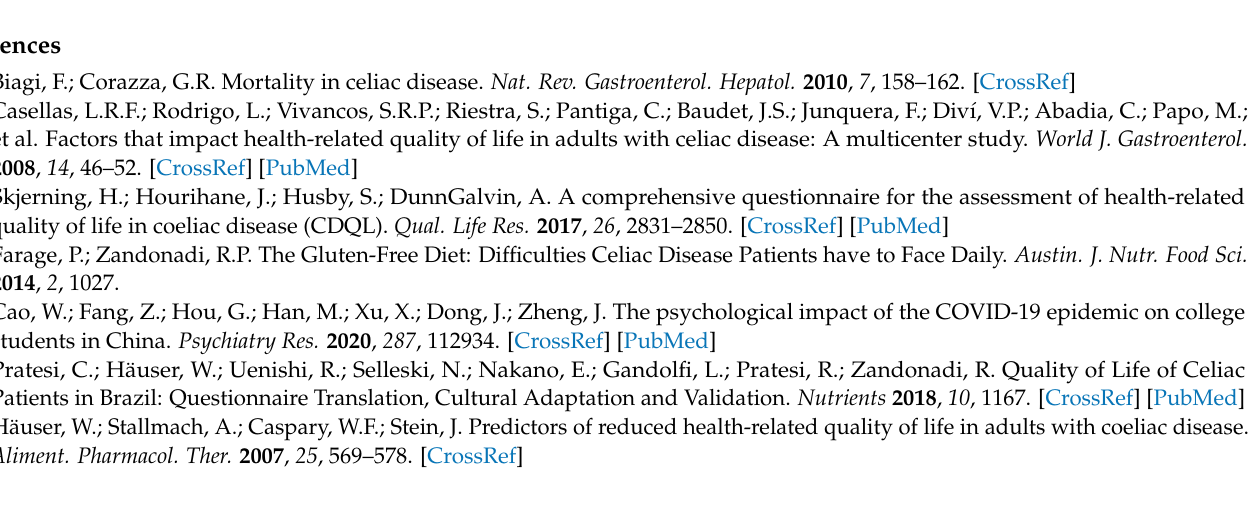
study sample; Table S2: Comparison between the application of the CDQoL questionnaire before and during the Sars-Cov-2